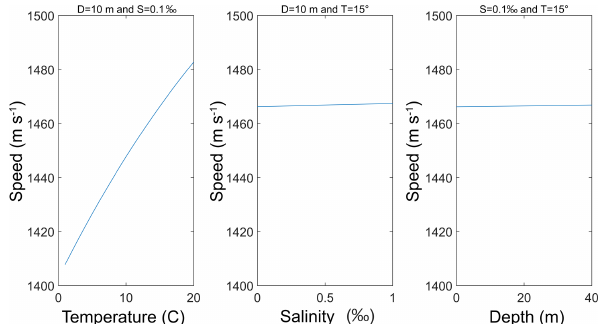
Figure A1. Sound speed for varying temperature, salinity, and